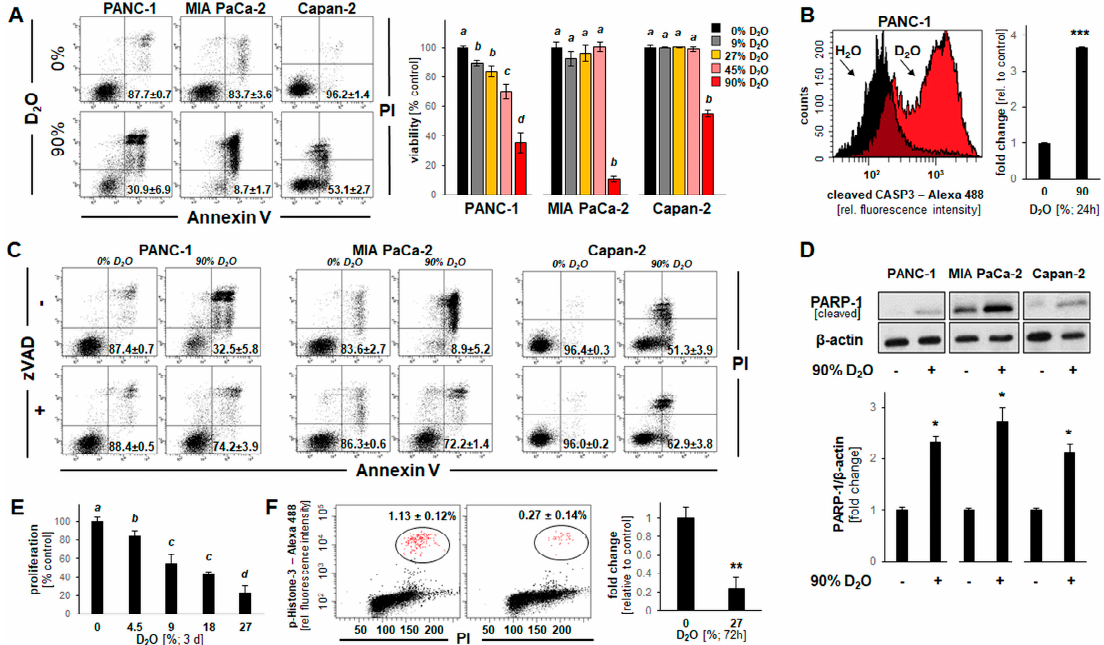
Figure 2 Figure 2. D 2 O-induced apoptosis in a panel of human pancreatic ductal adenocarcinoma cells (PANC-1, MIA PaCa-2, and Capan-2). ( A ) Loss of cellular viability in response to D 2 O (90%, 24 h) as analyzed in Figure 1A. ( B ) D 2 O-induced (90%, 24 h) induction of pro-caspase 3 cleavage examined in PANC-1 cells by flow cytometry (left panel: representative histograms; right panel: bar graph depiction of numerical analysis ( n = 3; p *** < 0.001). ( C ) D 2 O-induced (90%, 24 h) cell death examined in the absence or presence of zVAD-fmk (40 µ M). ( D ) PARP-1 cleavage in response to D 2 O-exposure (90%, 24 h) observable in pancreatic ductal adenocarcinoma (PDAC) cells by immunoblot analysis; bar graph depiction summarizes densitometric analysis ( n = 3; p* < 0.05). ( E ) Impairment of cellular proliferation (PANC-1) by culture in D 2 O ( ≤ 27%, 3 days). ( F ) M-phase depletion as a function of culture in D 2 O (27%, 3 days) as assessed and analyzed in Figure 1D ( n = 3; p ** <